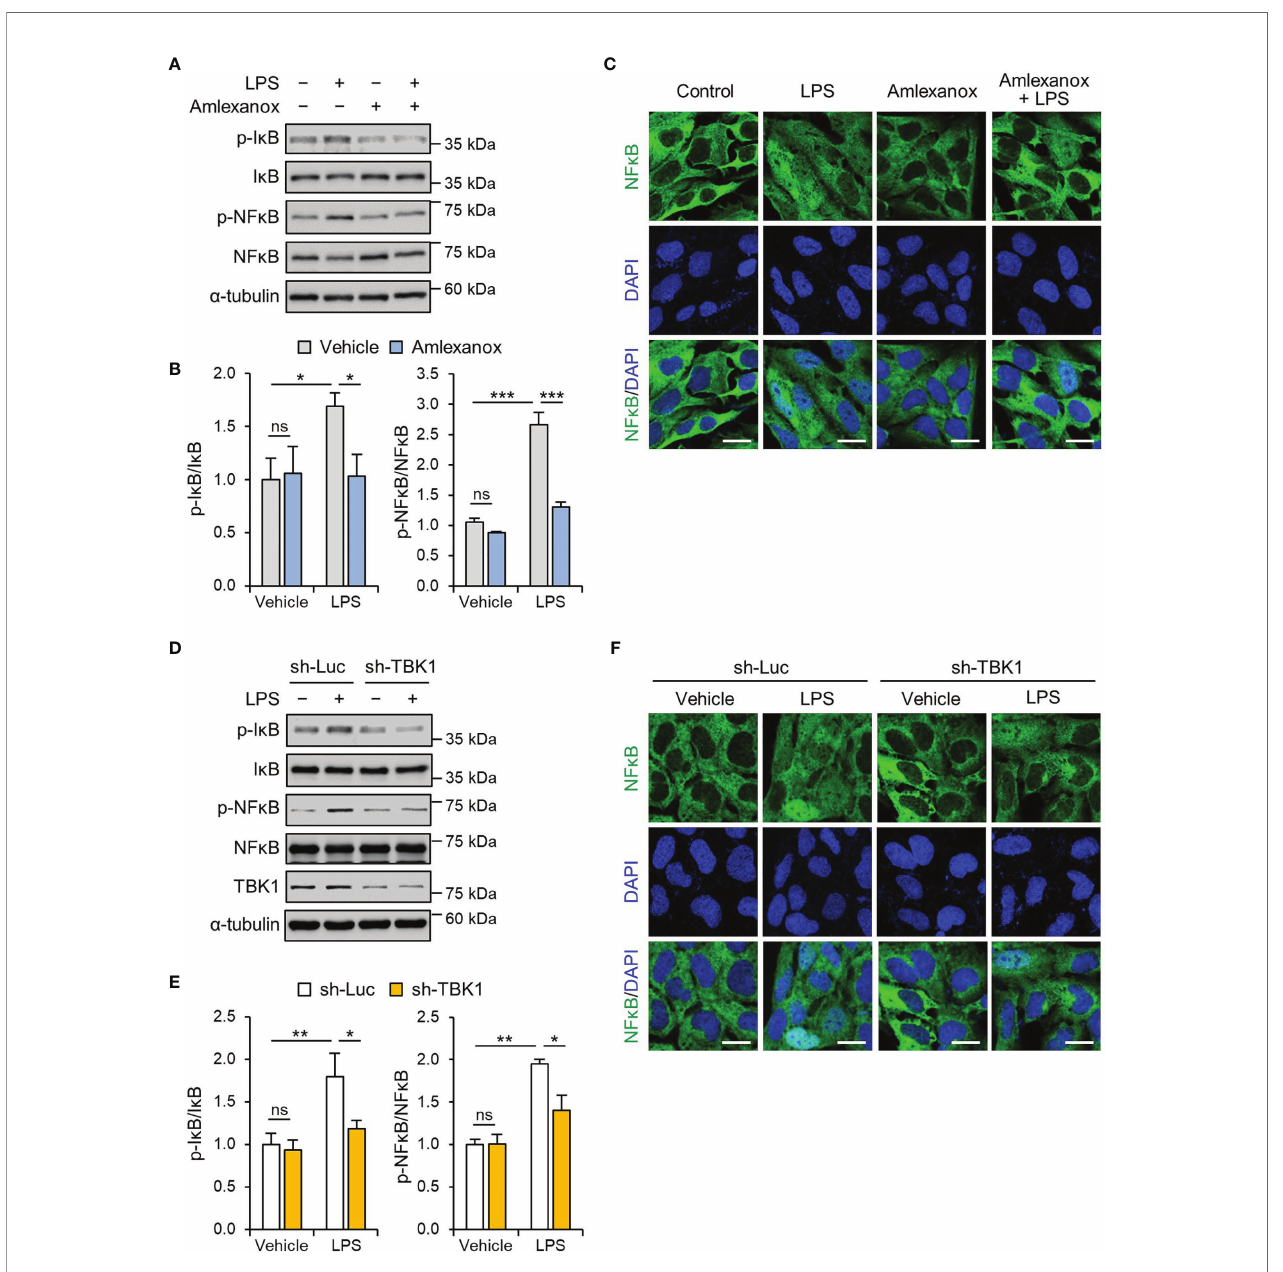
FIGURE 3 | TBK1 de fi ciency abolishes LPS-induced NF- k B/p65 activation in trophoblasts. (A, B) HTR-8/SVneo cells were treated with 1 m g/mL LPS or 100 µM amlexanox for 1 h, as indicated in the fi gure. Cell lysates were analyzed by immunoblotting with anti-p-I k B a , anti-I k B a , anti-p-p65, and anti-p65 antibodies. a -tubulin served as a loading control. (C) Immuno fl uorescence staining of p65 (green) in HTR-8/SVneo cells treated with 1 m g/mL LPS or vehicle for 45 min in the presence or absence of 100 µM amlexanox. Nuclei were stained with DAPI (blue). Scale bars, 20 m m. (D, F) HTR-8/SVneo cells were infected with lentiviruses expressing shRNAs targeting luciferase (sh-Luc) or TBK1 (sh-TBK1) and treated with 1 m g/mL LPS for 1 h, as indicated in the fi gure. Cell lysates were analyzed by immunoblotting with anti-p-I k B a , anti-I k B a , anti-p-p65, and anti-p65 antibodies. a -tubulin served as a loading control. (E) Immuno fl uorescence staining of p65 (green) in HTR-8/SVneo cells infected with sh-Luc or sh-TBK1 lentiviruses and treated with 1 m g/mL LPS or vehicle for 45 min. Nuclei were stained with DAPI (blue). Scale bars, 20 m m. Data are shown as means ± SEM. Results are representative of at least three independent experiments. * p < 0.05; ** p < 0.01; *** p < 0.001; ns, not signi fi cant (One-way ANOVA, followed by Tukey ’ s tissues. Immunoblot analysis revealed that phosphorylation of NF- k B/p65 was increased, whereas amlexanox treatment prevented the increase in phosphorylation levels of NF- k B/p65 expression of IL-1 b , IL-6, IL-10, TNF- a , TGF- b 1, MCP-1, and IFN- b genes was elevated in the placenta of LPS-treated mice as